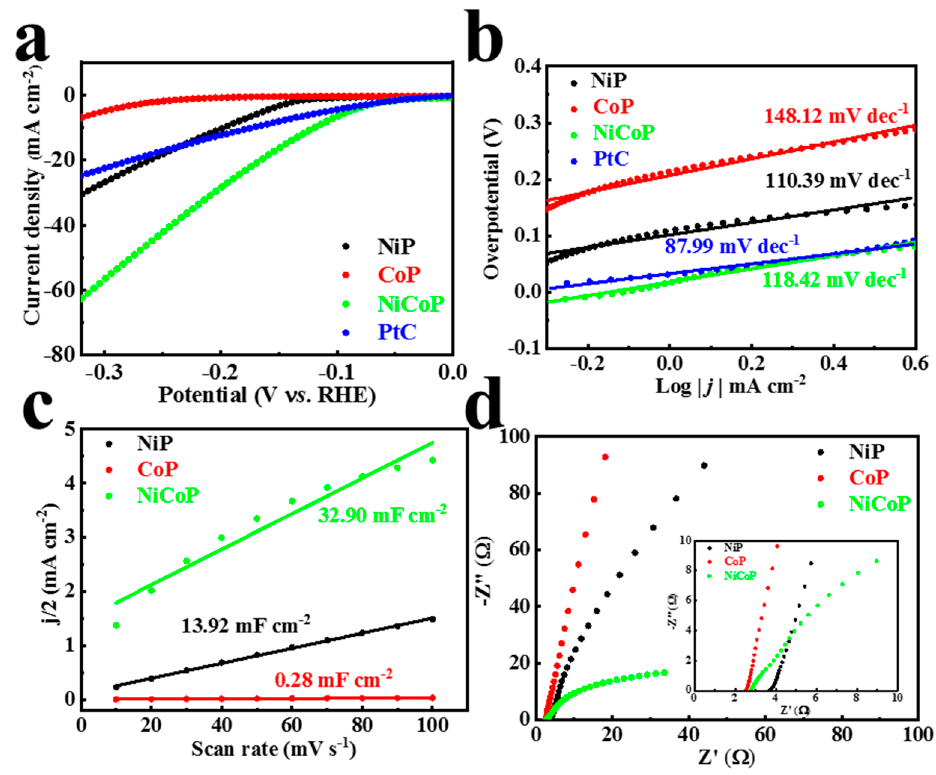
Figure 5. ( a ) LSV curves and ( b ) Tafel plots of NiP, CoP, NiCoP 1 h, and PtC. ( c ) C dl and ( d ) EIS Nyquist plot of NiP, CoP, and NiCoP 1 h in 1 M KOH for HER; the inset presents the plot enlarged over the high frequency range.